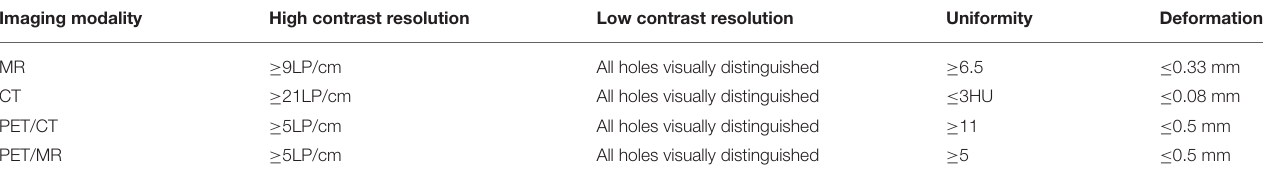
TABLE 4 | Summary of image parameters of the 3D-printed phantoms with respect to imaging modality. Imaging